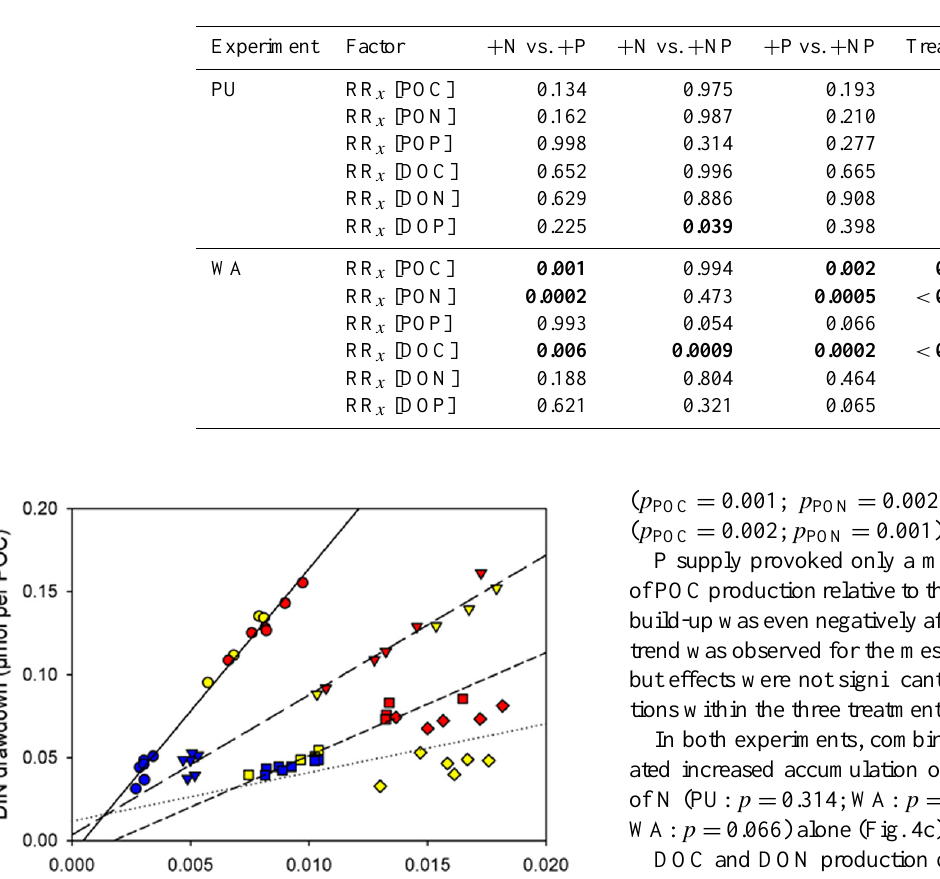
Table 2. Summary of p -values obtained from ANOVA comparing the effects of the three high nutrient enrichment treatments ( + N, + P, or + NP) on build-up (POC, PON, POP, DOC, DON) or concentration (DOP) of organic elemental compounds during the PU and WA experiment. Statistically significant effects ( p < 0 . 05) are denoted in bold.